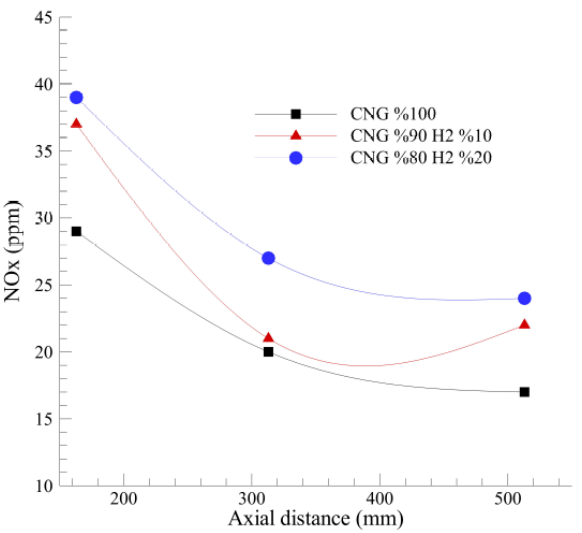
Figure 15: Axial NO x profiles (Swirl number: 0.4, Equivalence ratio: 0.9).